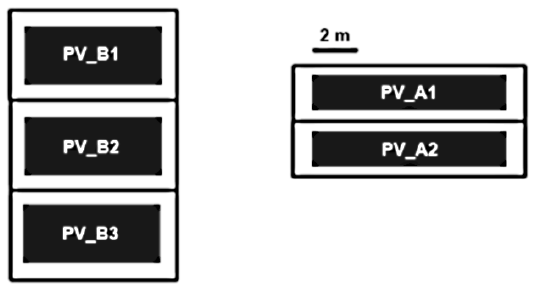
Fig. 8. Layout of the plant considered in case study